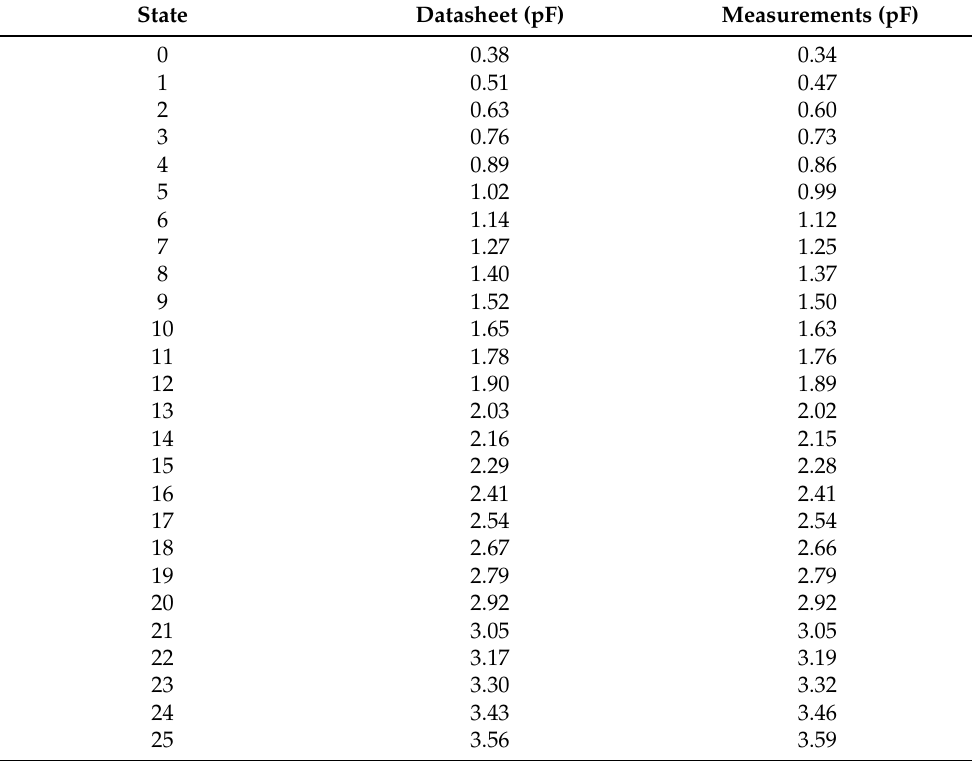
Table 1. Digitally tuneable capacitor